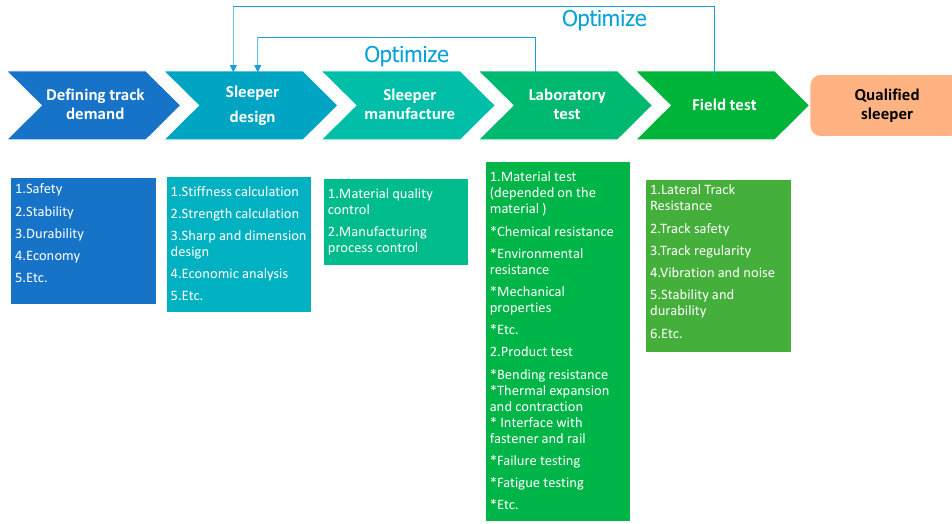
Figure 6. Composite sleepers develop process.